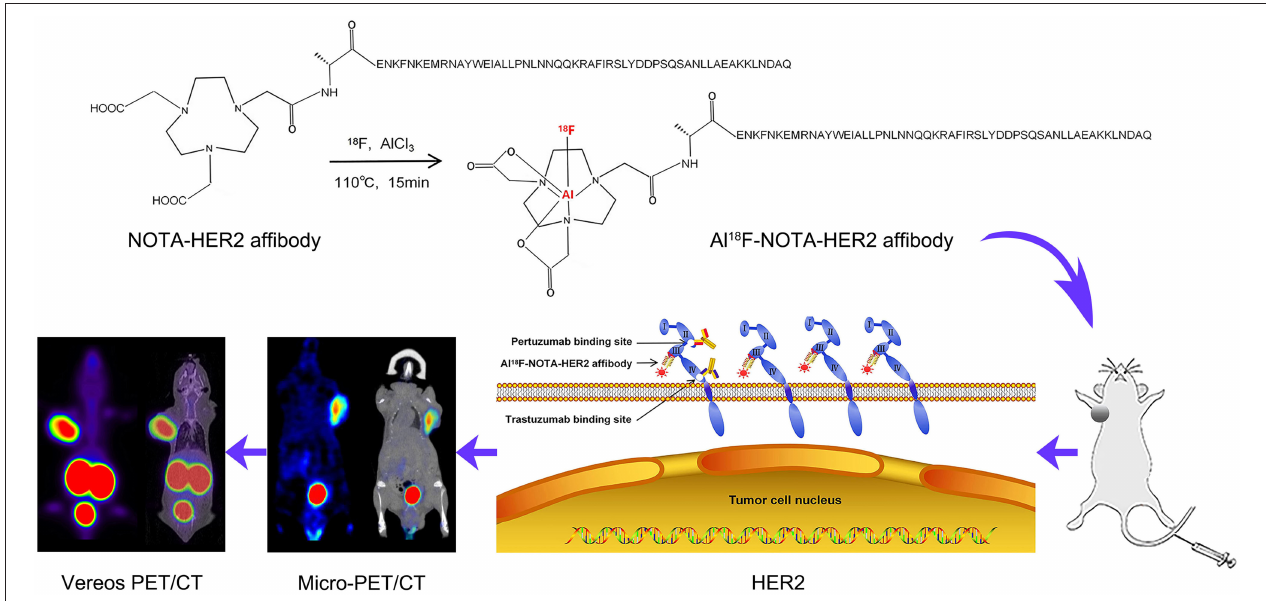
FIGURE 1 | Drug synthesis and experimental